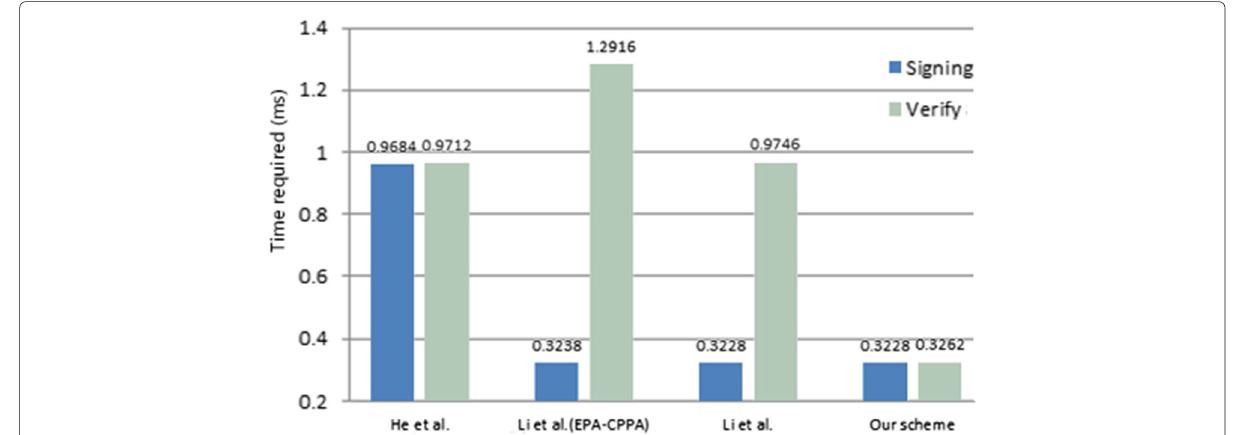
Fig. 4 Computation overhead of signing and